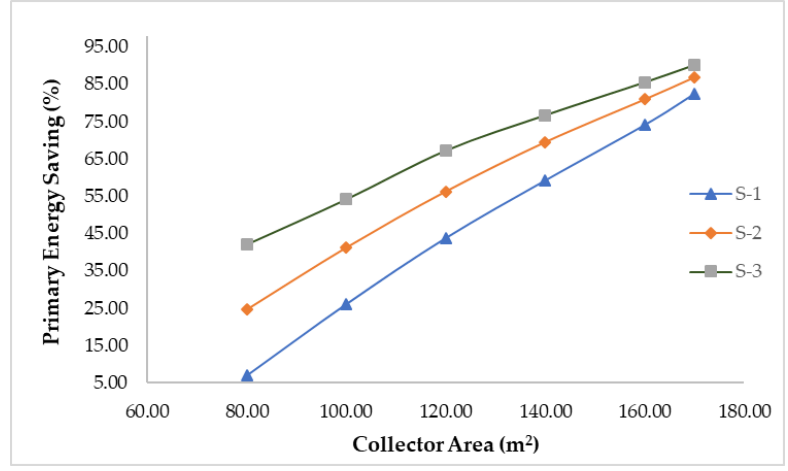
Figure 10. PES vs. ETC